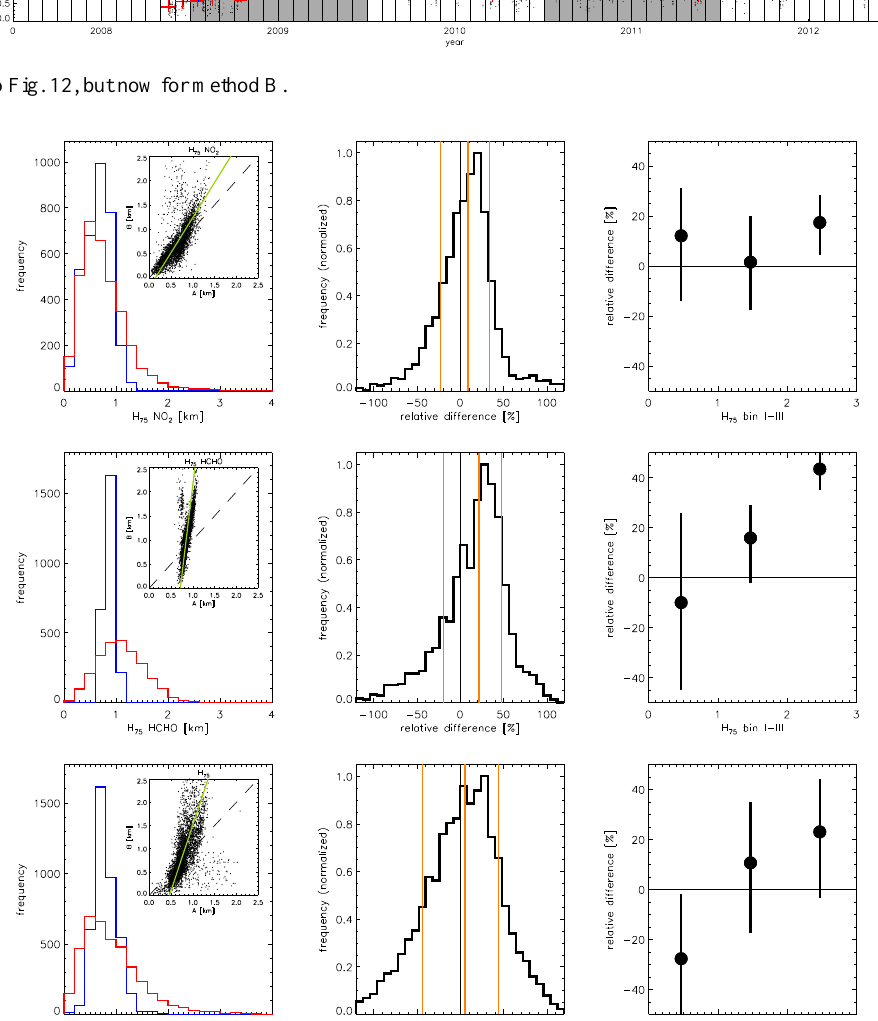
Figure 14. Statistics of characteristic profile height retrievals. The three rows refer to profile heights ( H 75 ) of NO 2 , HCHO and aerosols respectively. Left column: frequency distributions obtained with method A (blue) and B (red). Second column: frequency distribution of relative differences (B minus A). Lines in orange indicate the quartiles. Column 3: relative difference sorted as a function of H 75 where the three bins refer to the lowest 25%, middle 50% and highest 25%